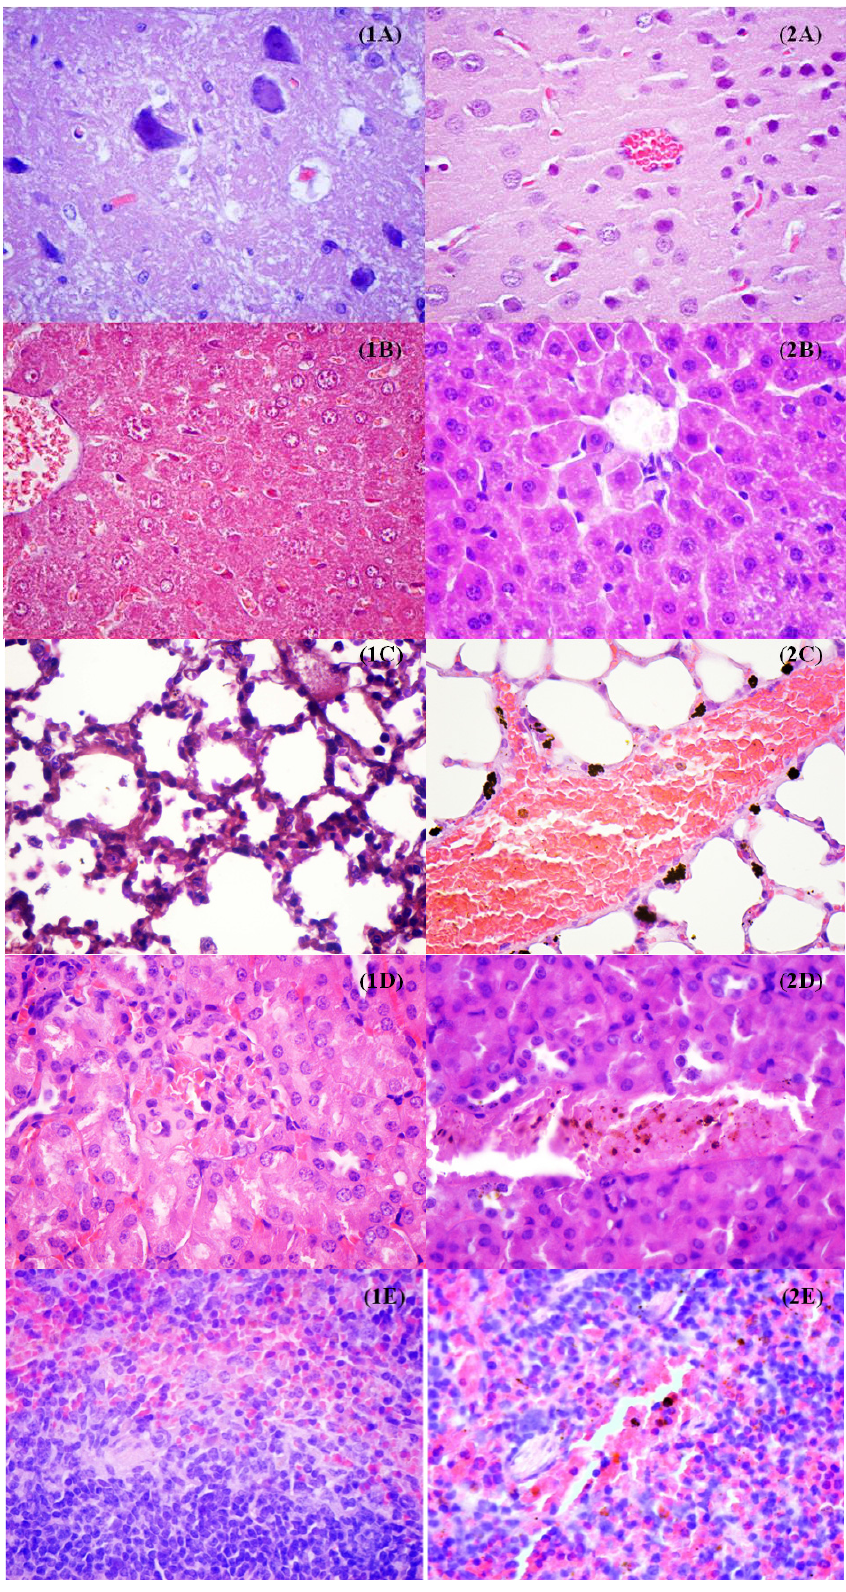
Figure 12. Transversal sections through different mice organs ( A = brain, B = liver, C = lung, D = kidney, E = spleen) in untreated control (1) and after the treatment with the obtained magnetite nanoparticles for 48 h (2); ×400